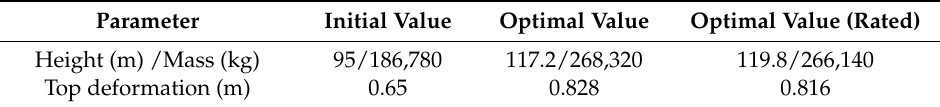
Table 7. Costs of rotor, tower, and foundation. Parameter